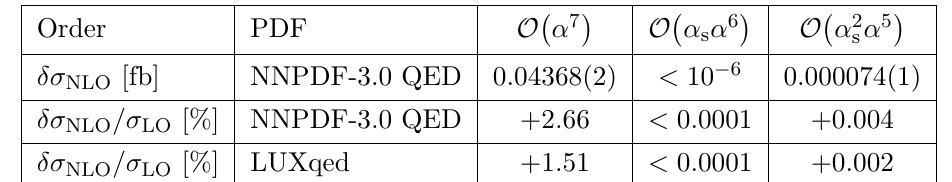
Table 4. Photon-induced NLO corrections for the process pp